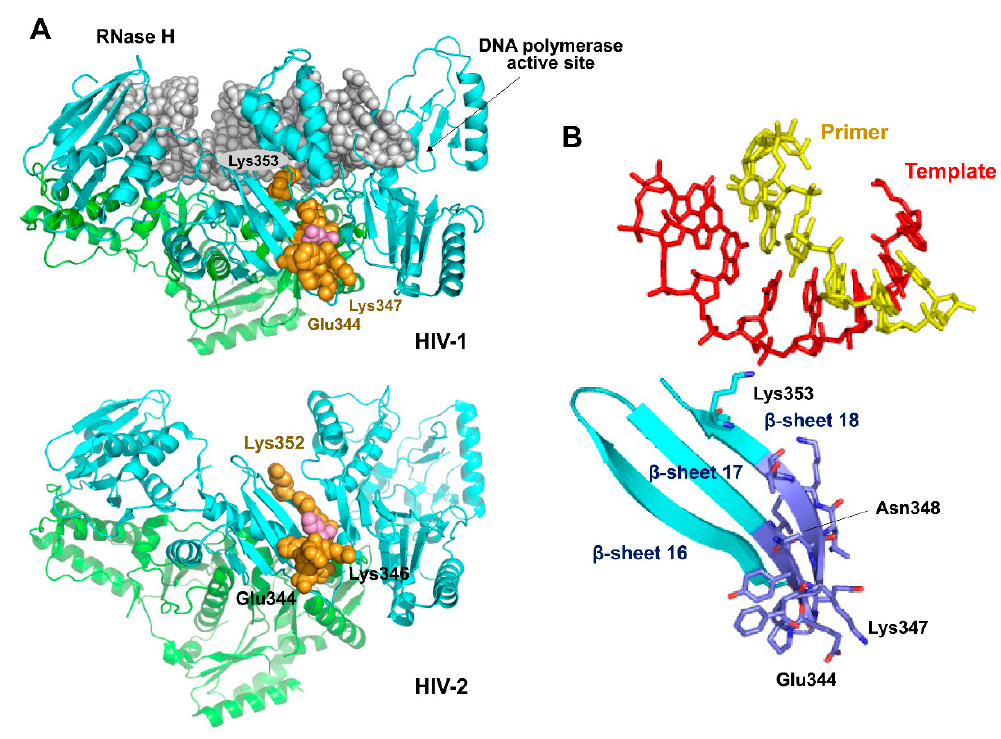
Figure 9. Location and structural context of Asn348 in HIV-1 and HIV-2 RTs. ( A ) Structure of a ternary complex of WT HIV-1 group M/subtype B RT bound to an RNA/DNA template-primer (upper panel) and unliganded HIV-2 ROD RT (lower panel). The position of the loop connecting β -sheets 17 and 18 in the large subunit of the heterodimer is indicated with a CPK model (orange spheres). Asn348 is shown in light magenta. ( B ) Close-up showing the location of relevant residues at the interaction site of Lys353 and the template strand of the RNA/DNA hybrid. Images were obtained with Pymol and the coordinates were taken from Protein Data Bank files 4B3P (HIV-1 RT) and 1MU2 (HIV-2 RT).